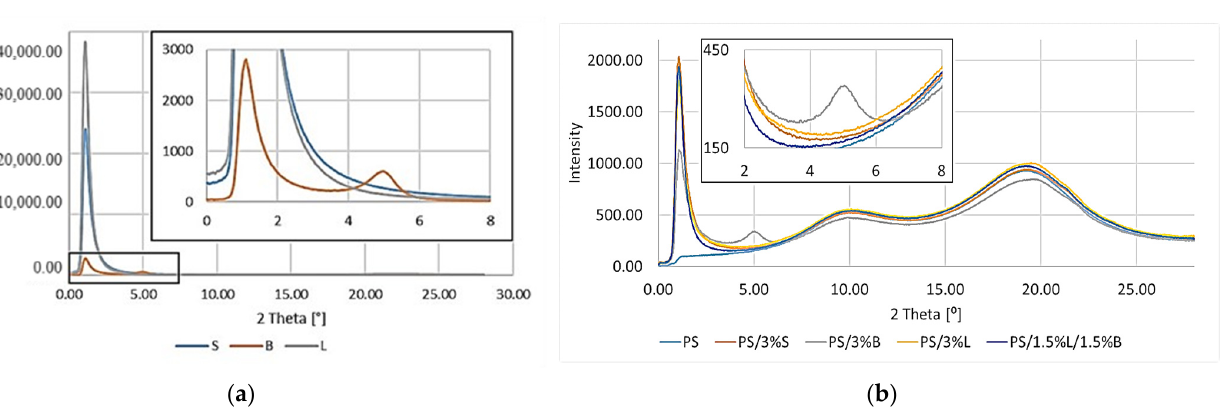
Figure 8. Results of the differential scanning calorimetry (DSC) analysis of PS and PS composites.